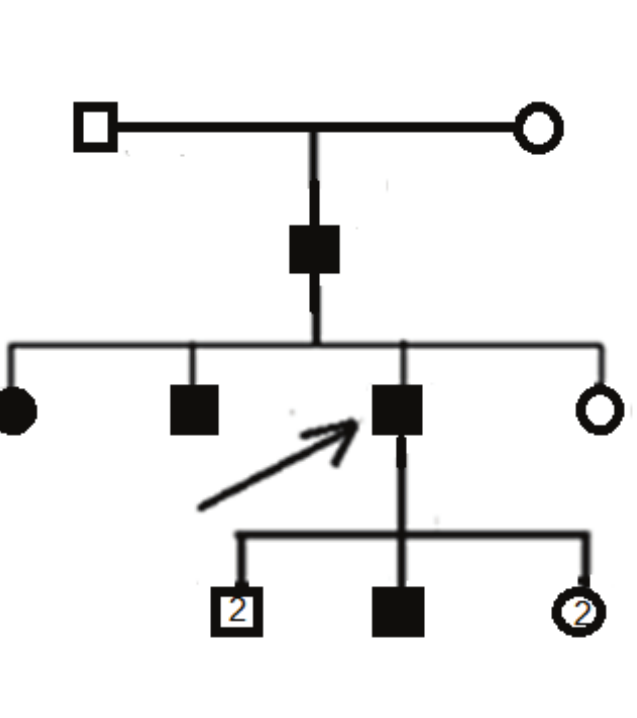
Figure 6 : Pedigree of the sixth family from the Northern State, Sudan with familial Bell’s palsy affecting five individuals (four male and one female) across three generations. The black arrow shows the index case. ( Note: The numbers inside the circles and rectangles indicate female and male family members in different generations and their subsequent generations who were unaffected by Bell’s palsy.